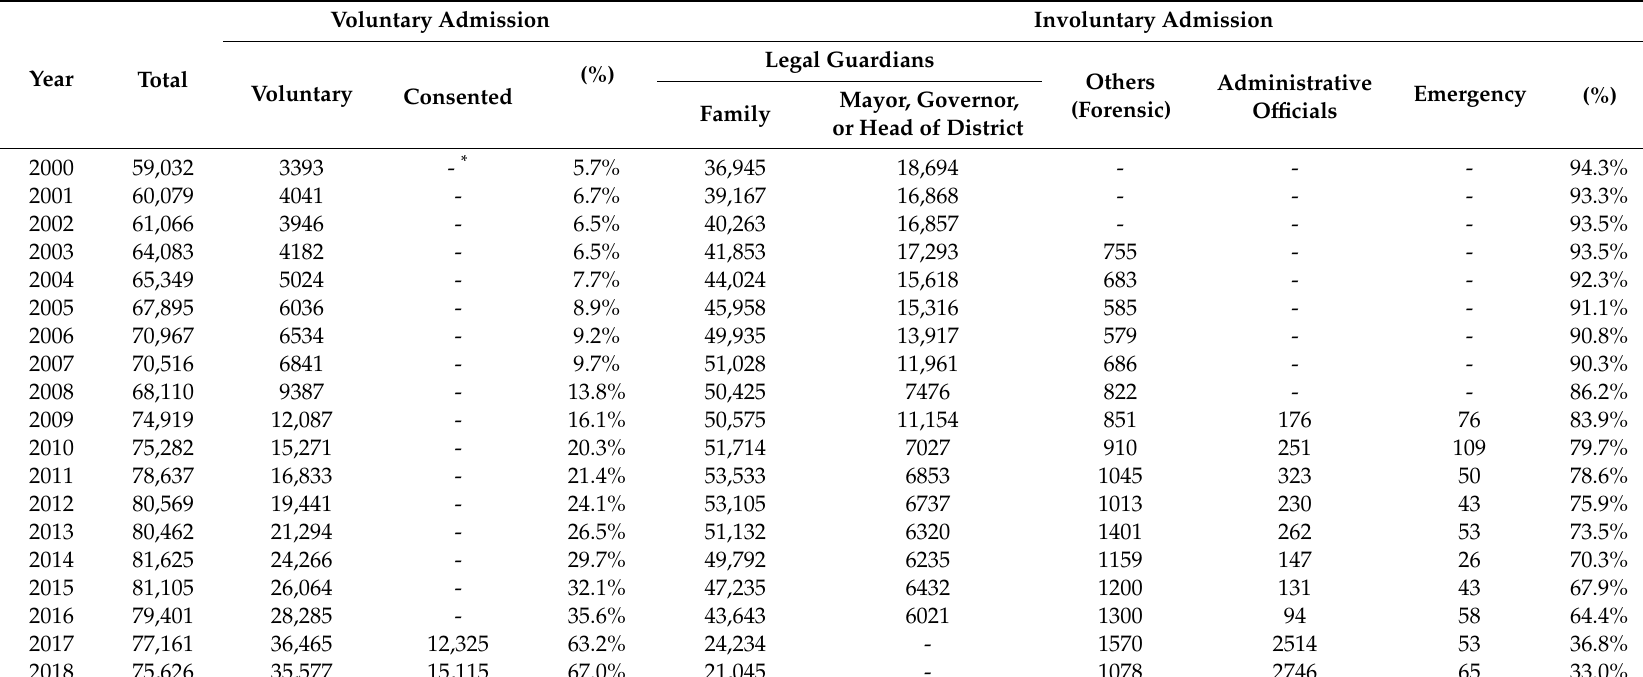
Table 3. Number of Psychiatric admissions by admission type in South